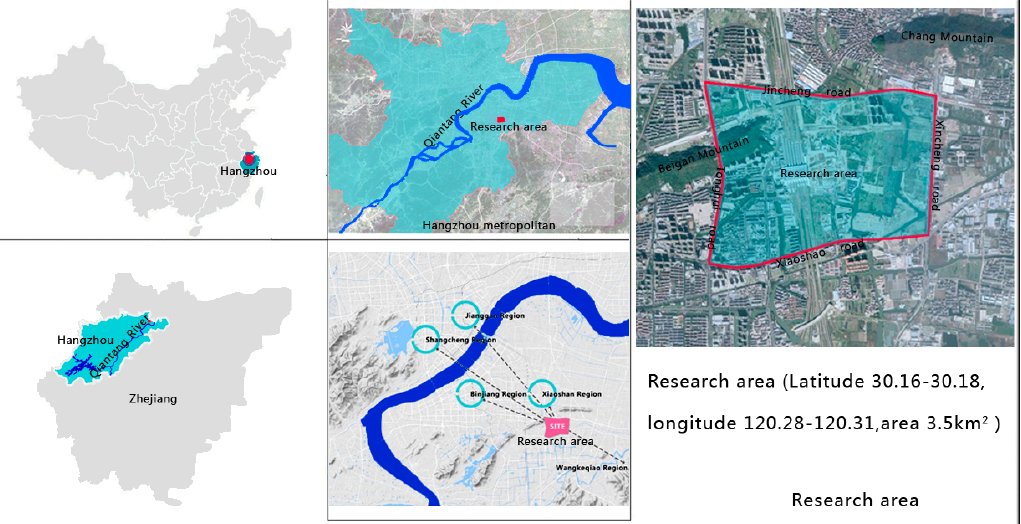
Figure 2. Location of the research area.